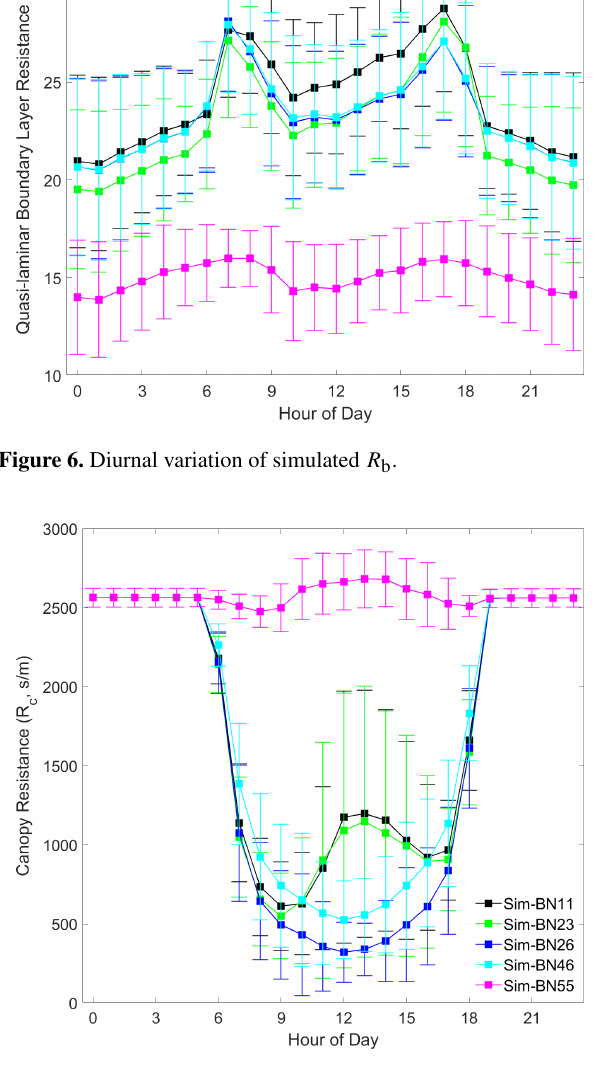
Figure 7. Diurnal variation of simulated R c